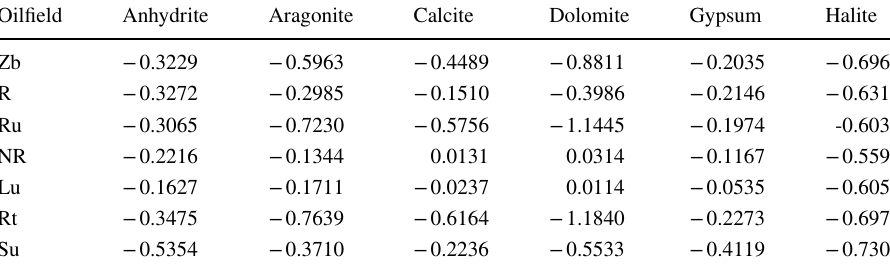
Oilfield Anhydrite Aragonite Calcite Dolomite Gypsum Halite